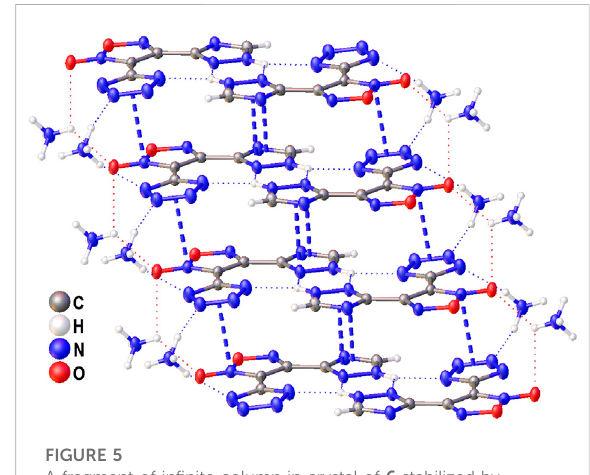
FIGURE 5 A fragment of in fi nite column in crystal of 6 stabilized by cation-anion H-bonds (dotted lines) and stacking interactions between anions (dashed lines).